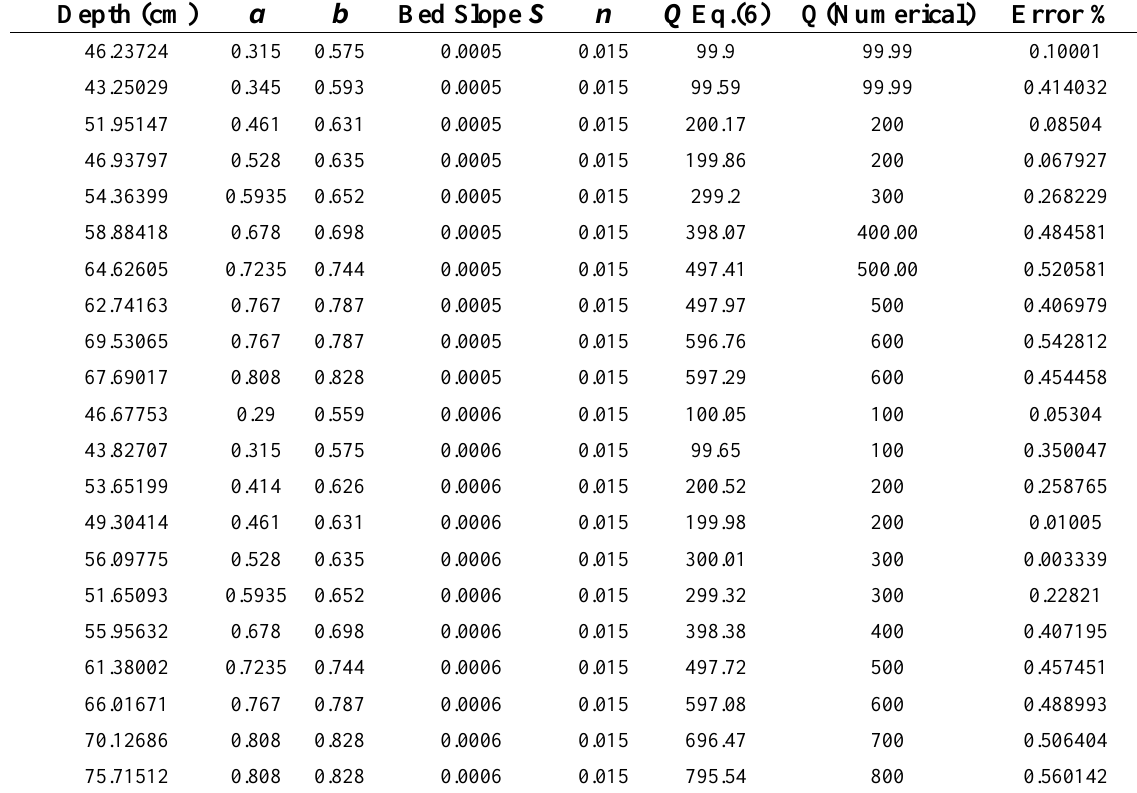
Table2. Percent of differences Between the Developed Equation and The Numerical Method Depth